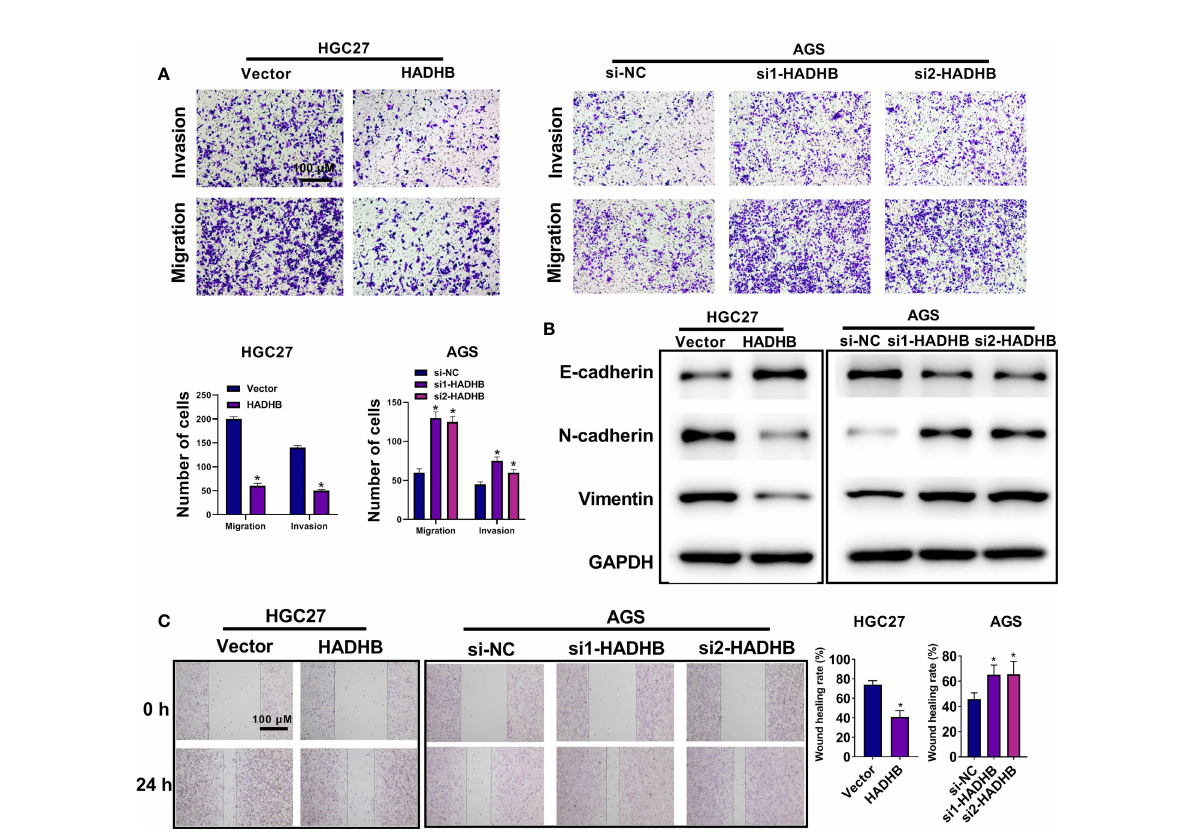
FIGURE 3 HADHB upregulation impeded the migration, invasion, and wound healing of HGC27 and AGS cells (A) . The invasion and migration of the transfected HGC27 and AGS cells were determined using the transwell assay. (B) . The expression of metastasis-related factors (Vimentin, N- cadherin, and E-cadherin) was evaluated using western blot analysis. (C) . Cell migration capacity of the transfected AGS and HGC27 cells was assessed using the wound healing assay. * P <